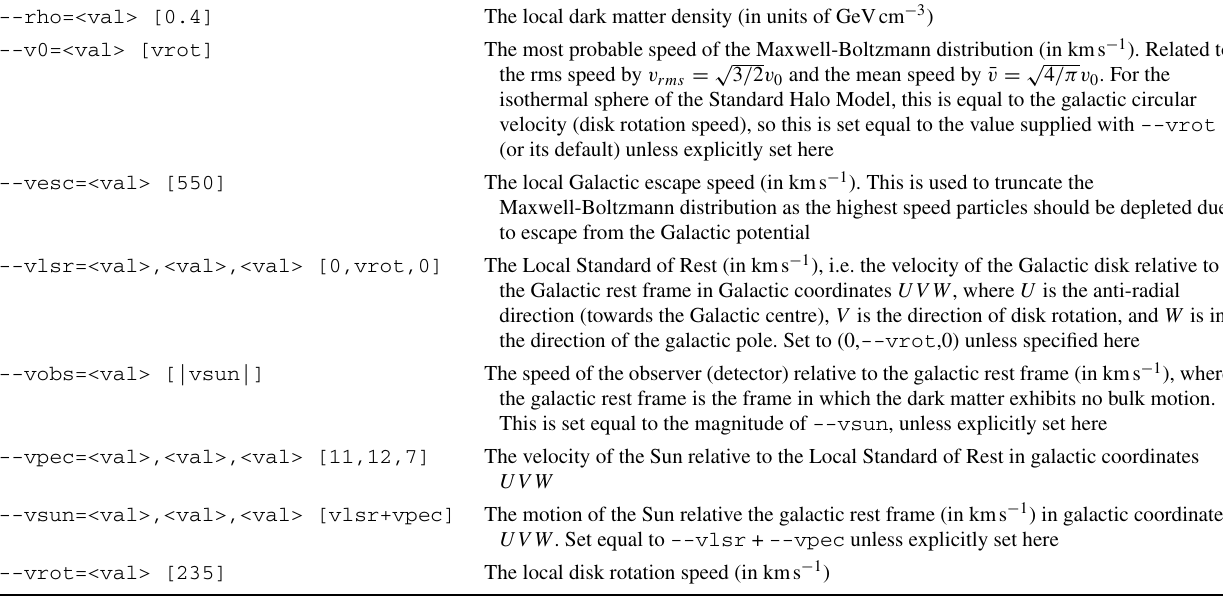
Table 5 Dark matter halo distribution options of the DDCalc default executable DDCalc_run --rho=<val>